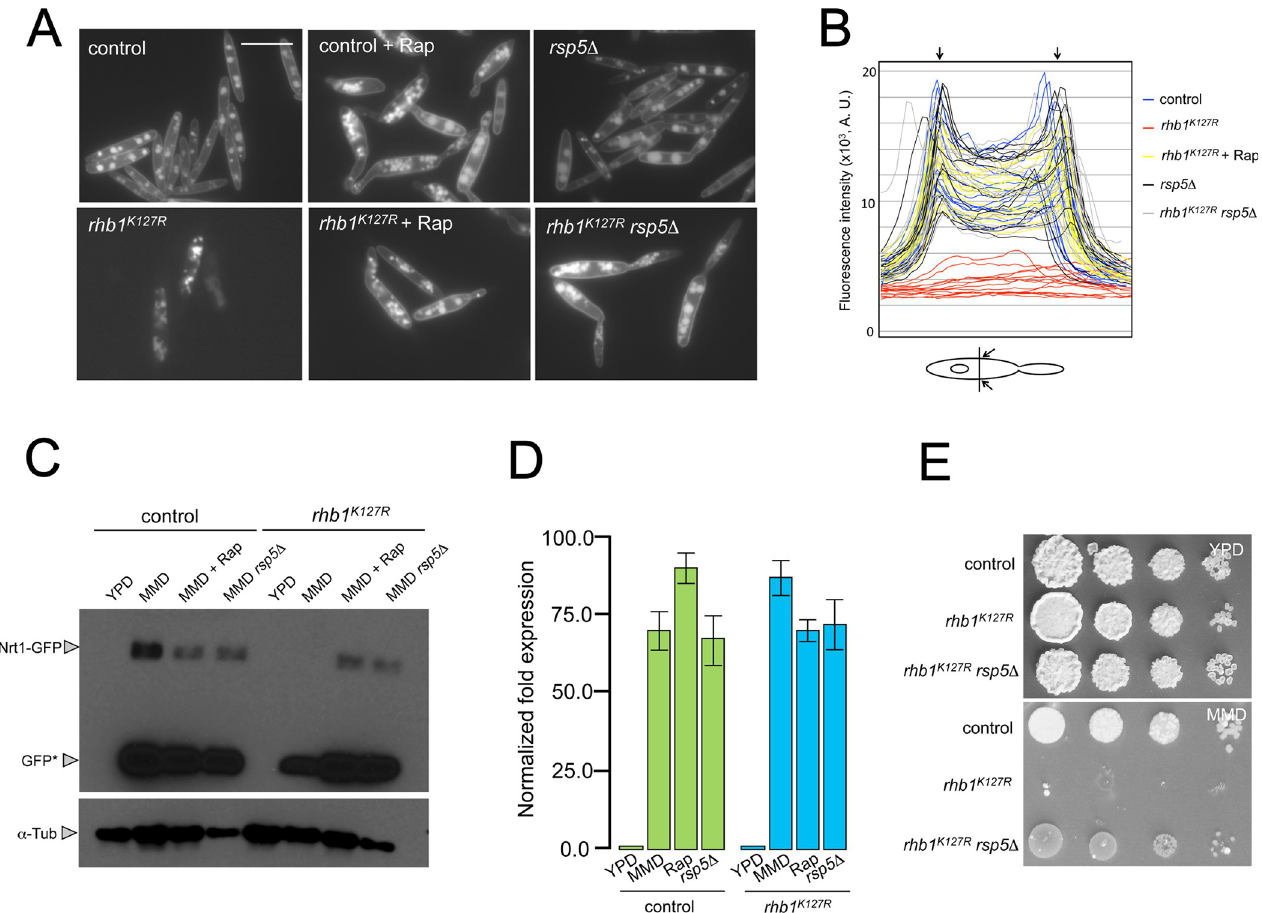
Fig 4. Forced activation of Rheb downregulates the nitrate permease. (A) Nitrate permease is not localized in cells expressing the rhb1 K127R allele at the plasma membrane. Fluorescence images of cultures from the indicated strains carrying an nrt1-GFP endogenous allele. Cells were grown for 8 hours in a minimal nitrate medium. Rapamycin (Rap) was added at 1 μ g/ml. All images were obtained using the same exposition time. Bar: 15 μ m. (B) Line-scan analysis of Nrt1-GFP signal intensities of cells from (A). At least 10 cells from each strain and condition were scanned through its medial zone. Arrows indicate the location corresponding to the plasma membrane. A. U., arbitrary units. (C) Nrt1 is degraded in cells expressing the rhb1 K127R allele in a TORC1-dependent manner. Western blot analysis of cell extracts with anti-GFP antibodies from the indicated strains carrying an nrt1 -GFP allele and expressing or not the rhb1 K127R allele, grown in different media for 8 hours. Rapamycin (Rap) was added at 1 μ g/ml. Levels of Tub1 were used as a loading control (bottom blot). (D) qRT-PCR for nrt1 from control (FB1 P crg1 : rhb1 ) and cells expressing the rhb1 K127R allele incubated for 8 hours in the indicated conditions (Rap: minimal nitrate medium amended with 1 μ g/ml Rapamycin; rsp5 Δ cells were incubated in minimal nitrate medium). Relative mRNA levels were referred to as the expression of tub1 . Each column represents the mean value of three independent biological replicates. Error bars represent the SD. (E) Loss-of-function of Rsp5 suppresses the growth defects associated with the expression of the rhb1 K127R allele in a minimal nitrate medium. Serial tenfold dilutions of cultures from the indicated strains (control: FB1 P : rhb1 ) were spotted in solid yeast peptone or minimal nitrate medium. YPD and MMD plates were incubated for 3 and 4 crg1 days at 28˚C.